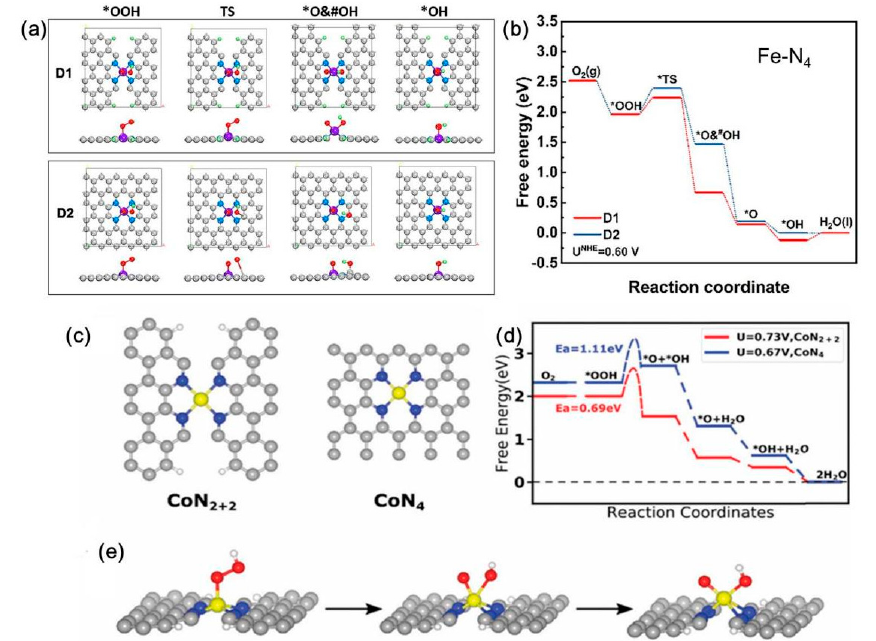
Figure 3. DFT calculations. ( a ) Structures of optimized configurations of adsorbed species on Fe-N 4 with D1 and D2 sites, H: green, C: grey, O: red, N: blue, Fe: purple; ( b ) free energy diagrams for the ORR on the Fe-N 4 D1 and D2 sites, Reproduced with permission from Ref. [55], Elsevier: 2021; ( c ) atomic structures of Co-N 2+2 and Co-N 4 active centers of Co-N-C catalyst; ( d ) the free energy evolution diagram of 4e − ORR pathway was calculated at the limiting electrode potential U = 0.73 V and the limiting electrode potential U = 0.67 V. ( e ) atomic structure of the initial (left), transition (middle) and final (right) states of the dissociation reaction at the Co-N 2+2 (where the gray, blue, yellow, red and white spheres represent C, N, Co, O and H atoms, respectively), Reproduced with permission from Ref. [56], Royal Society of Chemistry: 2019.